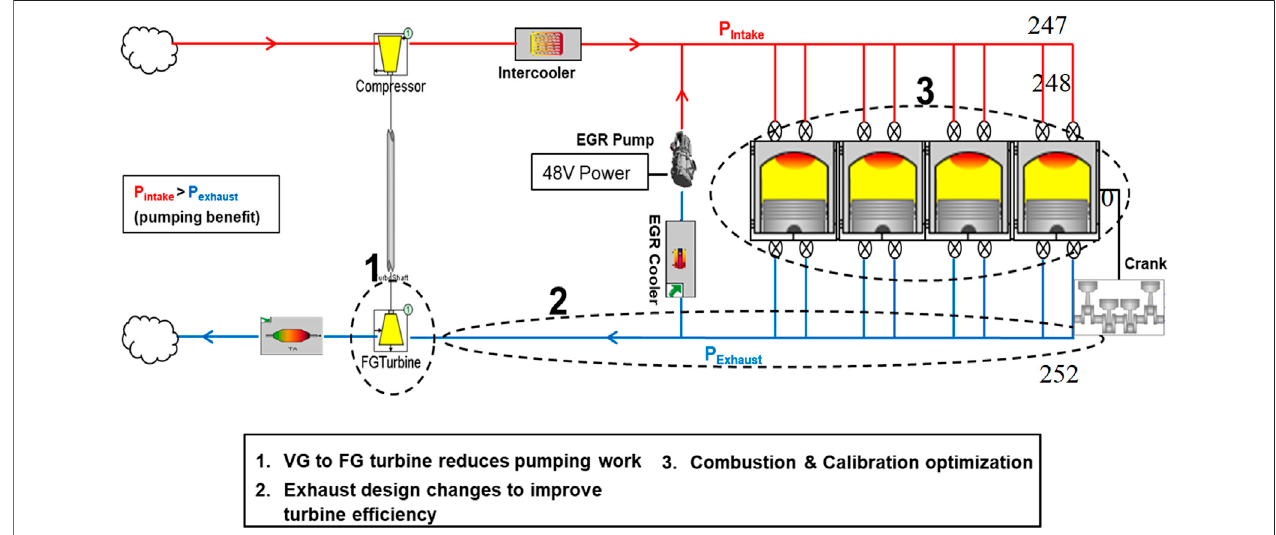
FIGURE 14 | Engine fl owchart with EGR